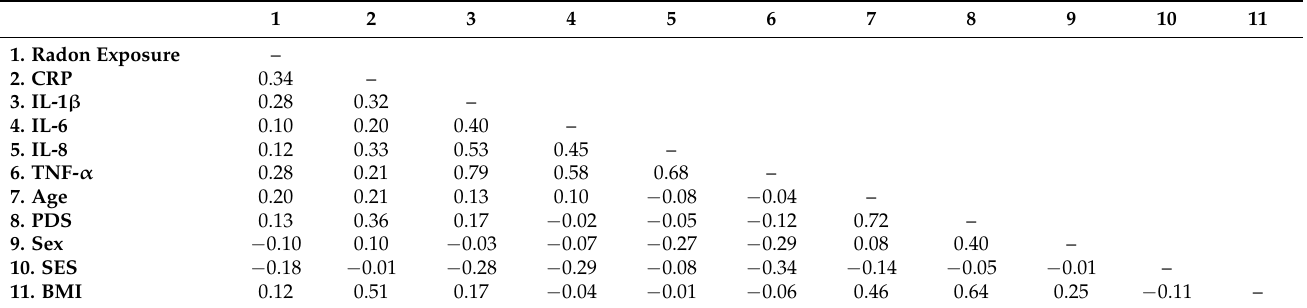
Table 3. Correlations among all variables included in the model.